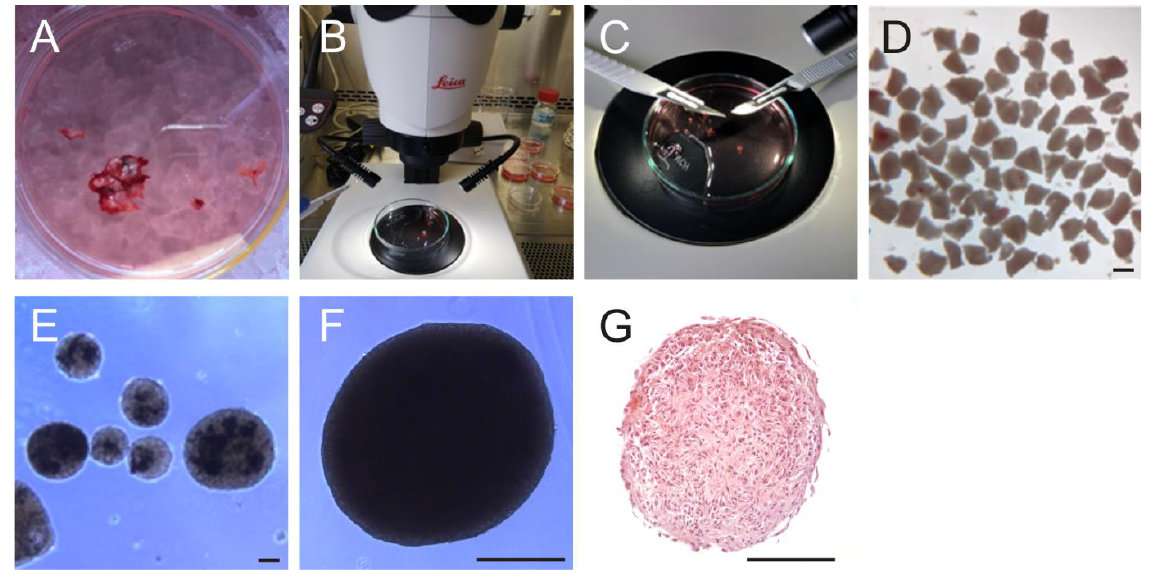
Figure 1. Preparation of GBM organoids. ( A ) Intra-operatively obtained tumor tissue was stored on ice in Hibernate A medium. ( B – D ) Under a stereo microscope, the tumor was minced into pieces of 0.5 mm, which were cultured. Scale bar = 0.5 mm. ( E ) The edges rounded up and organoids formed after two weeks. ( F ) Perfectly formed organoid. Organoids can be cultured for several weeks, propagated by mincing into 100 µm large pieces and re-grown or stored frozen in liquid nitrogen. ( G ) H/E staining of a cross-section through an organoid after 4 weeks of culture. Scale bars in ( E – G ) = 100 µm.